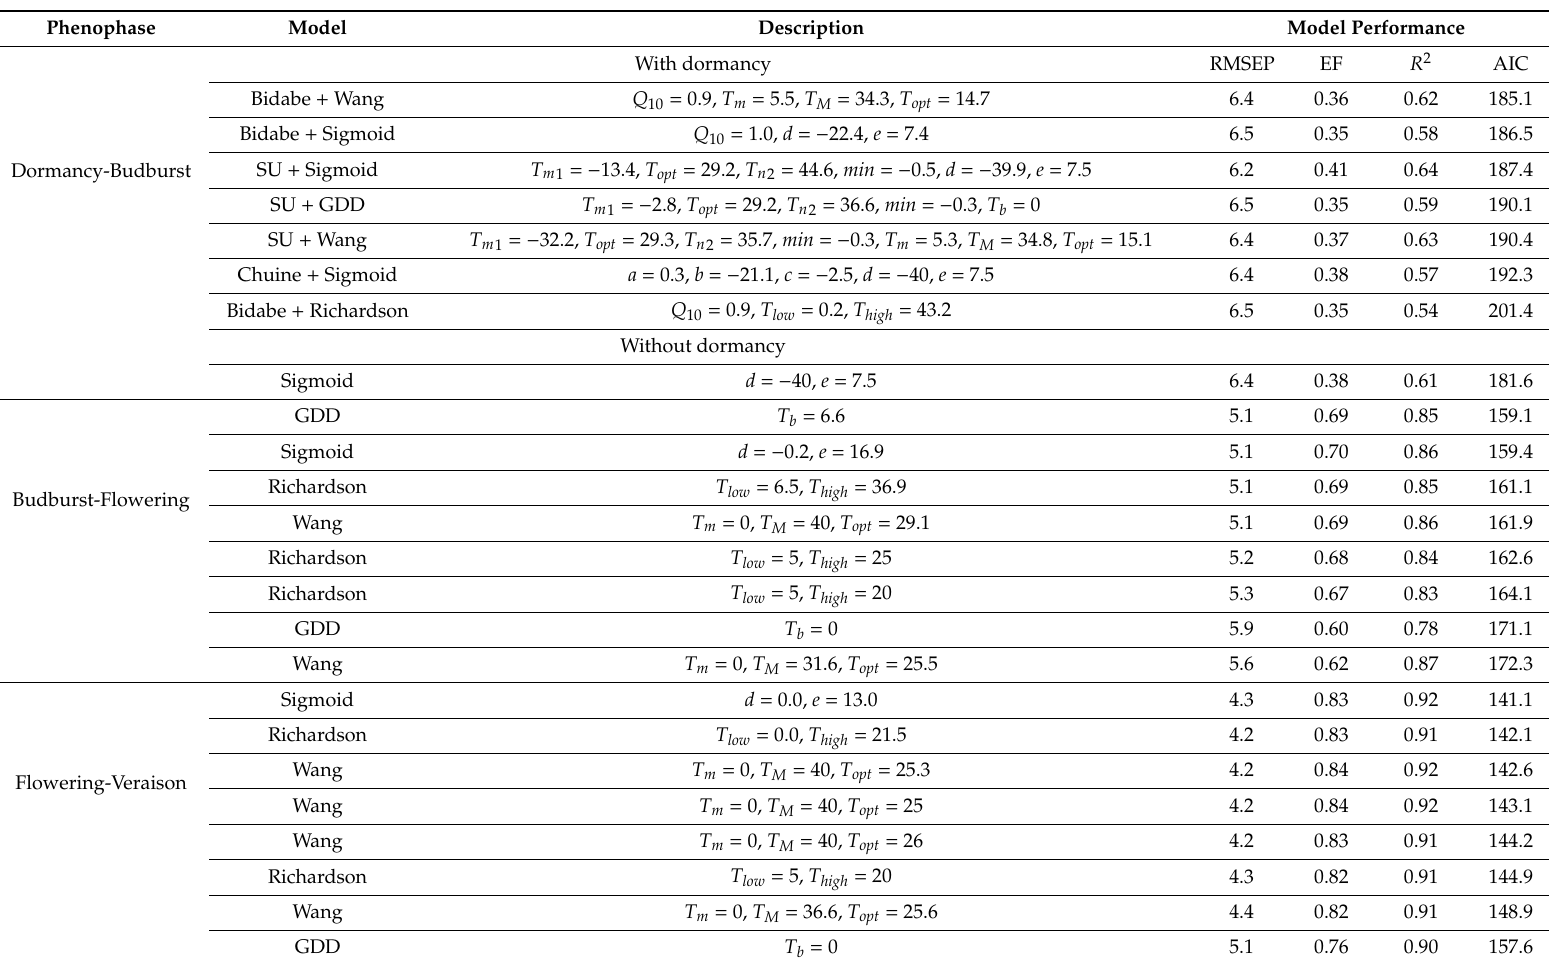
Table 5. List of the selected phenological models for cv. Touriga Franca and for each phenophase (D-B, B-F, and F-V), accompanied by the corresponding model performance parameters (Root Mean Square Error of Prediction (RMSEP), Nash–Sutcli ff e coe ffi cient of e ffi ciency (EF), determination coe ffi cient ( R 2 ), and Akaike Information Criterion (AIC)). Models are sorted according to their model performance based on